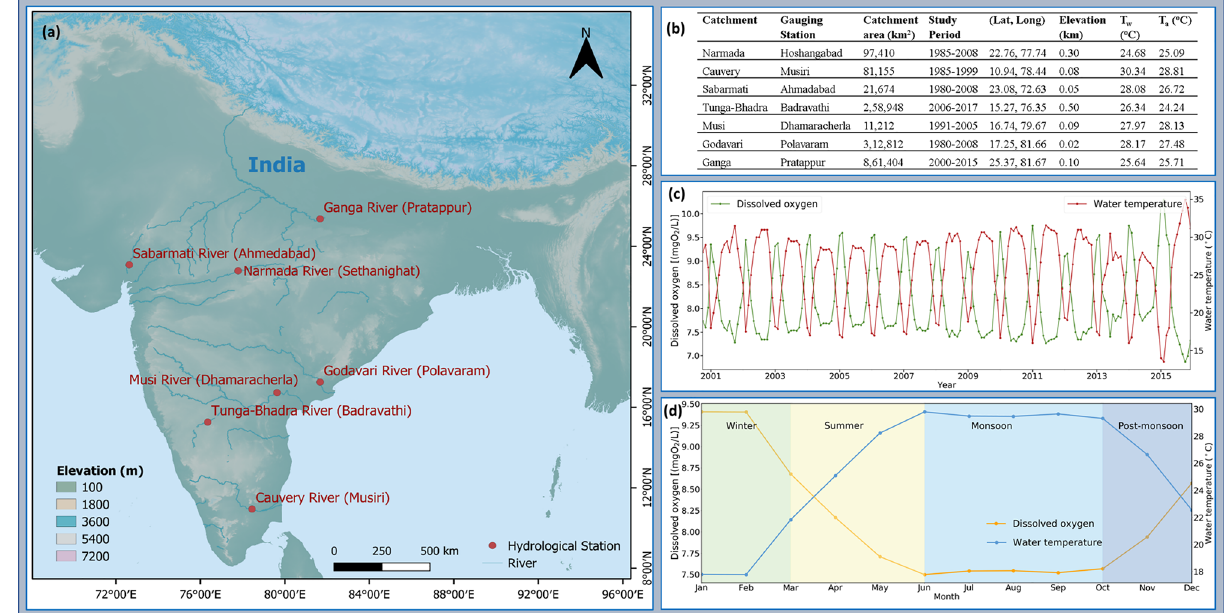
Figure 1. ( a ) Location map of study sites in India, ( b ) summarized all catchments and gauging station information in tabular form, ( c ) time series of monthly dissolved oxygen concentration (mgO 2 /L) and water temperature (°C) for the period 2001–2015 at Ganga catchment, and ( d ) monthly mean dissolved oxygen concentration (mgO 2 /L) and water temperature (°C) based on 14 years average at Ganga catchment for the period 2001–2015. The map was created using QGIS v3.4.14 (https:// qgis. org), Python v3.7.4 (https:// www. python. org), and post-processed with PowerPoint v2018 (https:// micro soft.